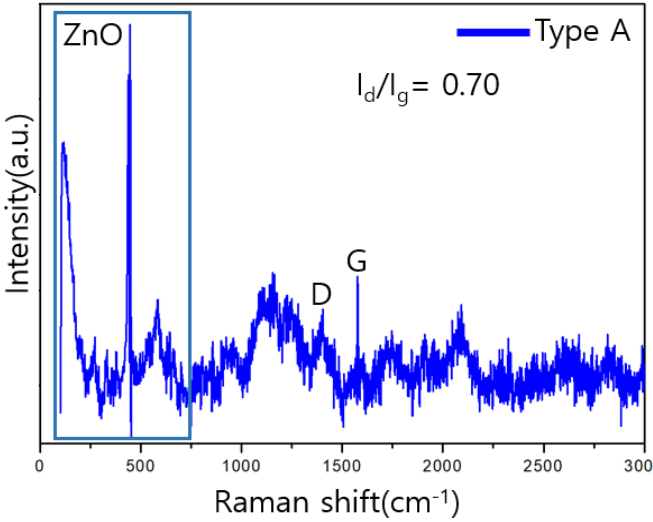
Figure 7. Raman analysis results for type A samples.